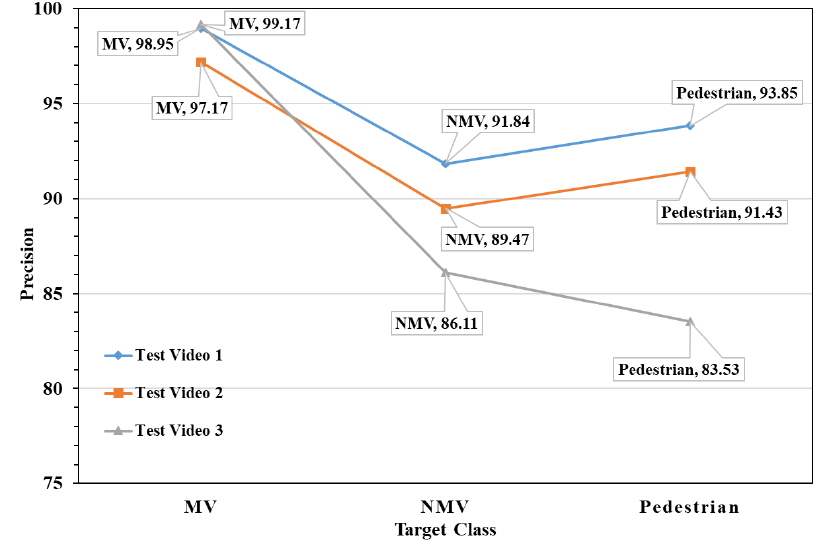
Figure 8. Precision calculation of target classes on three captured test datasets.